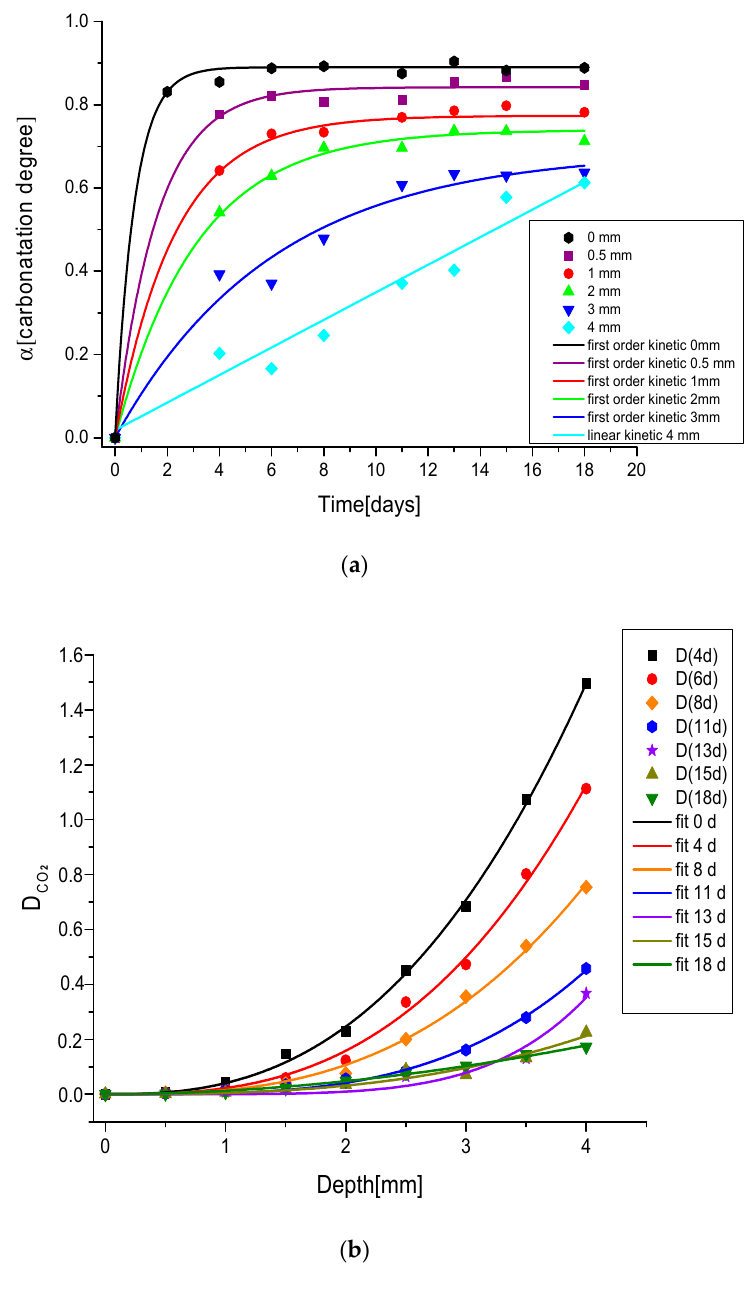
Figure 7. ( a ) Kinetic model in depth for a sample heated at 200 °C, ( b ) diffusion coefficient for unit of [CO 2 ] in a sample heated at 200 °C as a function of carbonation depth at different days of air unit of [CO 2 ] in a sample heated at 200 ◦ C as a function of carbonation depth at different days of exposure. air